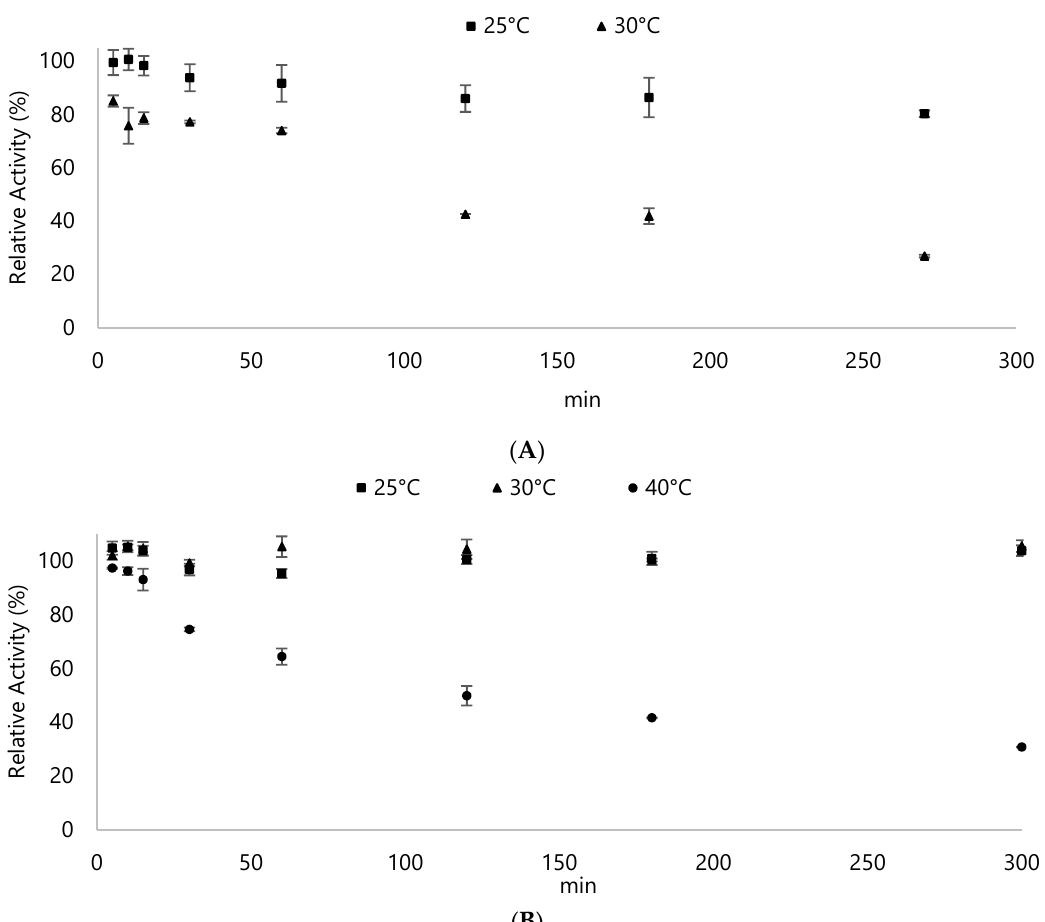
Appl. Sci. 2021 , 11 , 7941